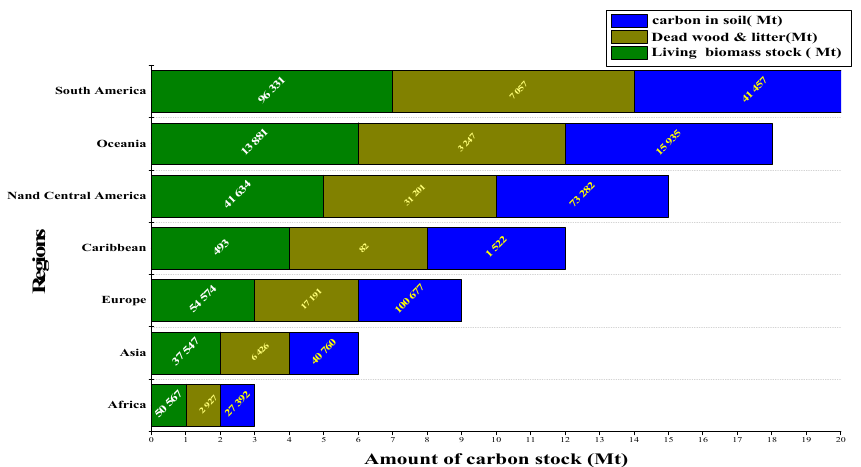
Figure 4. Distribution of carbon among different pools in forests and other wooded lands. Source; (FAO, 2020).